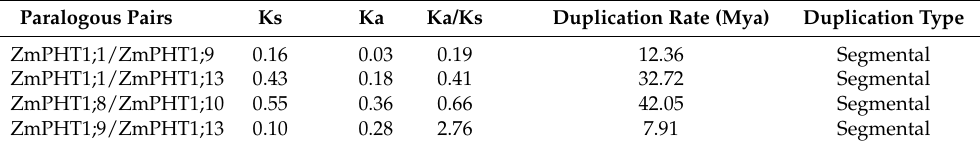
Table 2. Estimates of the dates for duplication events in maize PHT1 paralogs.